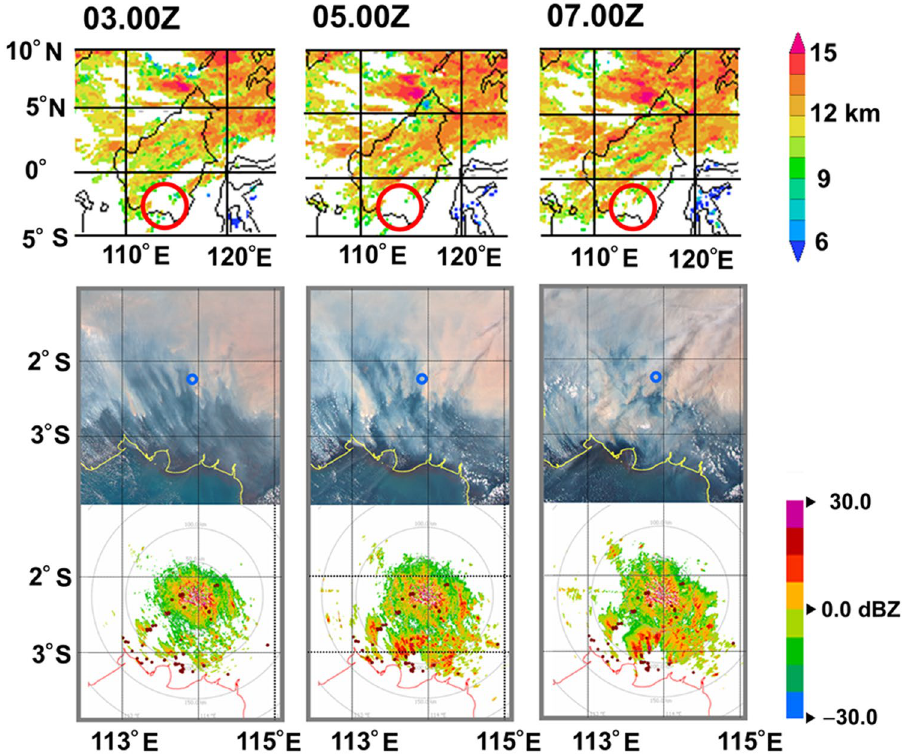
Figure 2. Lower: Radar echo images observed on 15 October 2015 from 03Z (10LT) to 07Z(14LT) with PPI = 0.5˚. Radar is located at the Tjilik Riwut BMKG station of Palangka Raya. Red dots are MODIS fire hotspots. Note that radar images show the evolution of the planetary boundary layer and fire plume trails. Middle: Corresponding AHI/HIMAWARI-8/JMA satellite images. The blue circle indicates the location of Palangka Raya. Upper: Cloud-top height and optical thickness estimates by RISH/KU. The white non-cloudy regions in the red circles cover the study areas. (Rainbow 5, https ://www.leona rdoco mpany .com/en/produ cts/ rainb ow-5-appli catio n-softw are), (Power Point